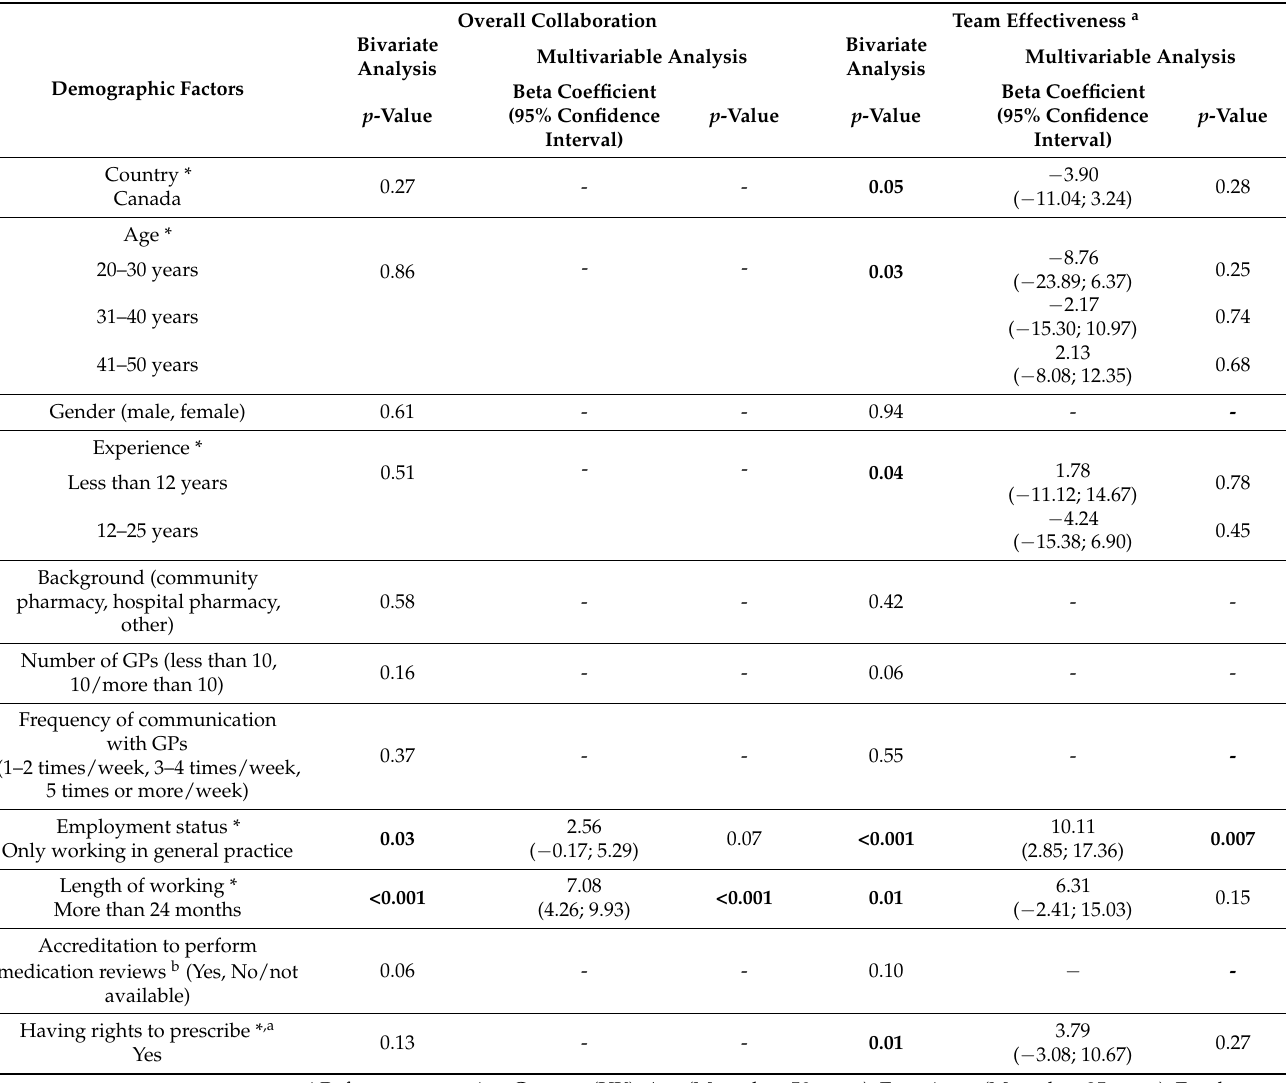
Table 3. Individual factors associated with interprofessional collaboration and team effectiveness of general practice